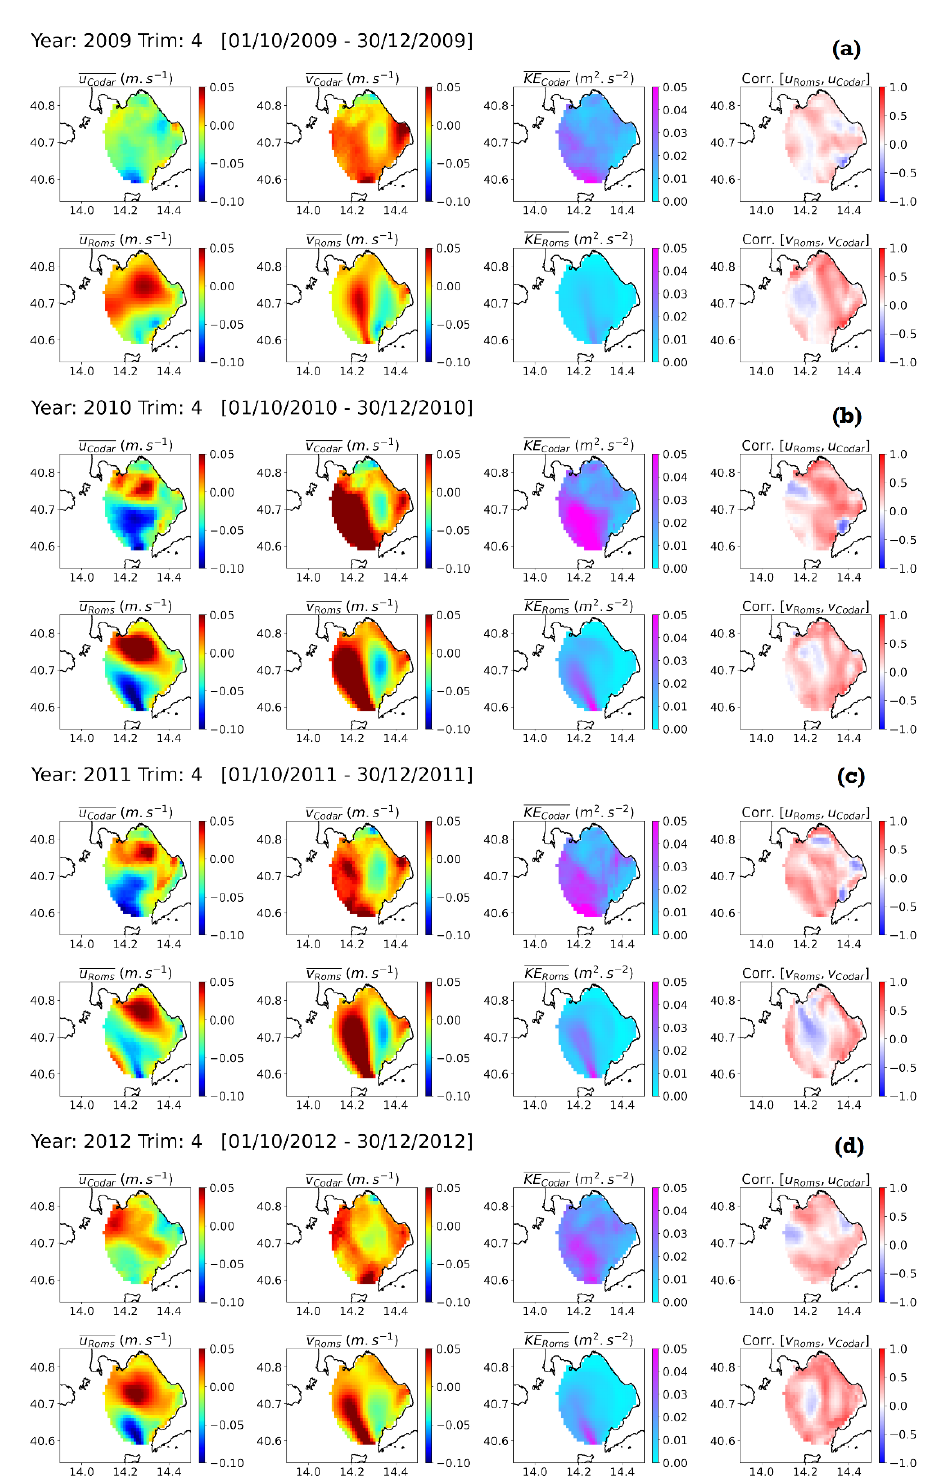
Figure 3. Average maps of velocities (components u , v ) and kinetic energy over the area covered by the Codar network (quality > 70%) in the Gulf of Naples, compared to the GNAM model, during the 4th trimestrial period of each year ( a ) 2009, ( b ) 2010, ( c ) 2011 and ( d ) 2012. For each grid point a correlation coefficient is calculated between the trimestrial time series of the velocity components, between numerical model and observations.